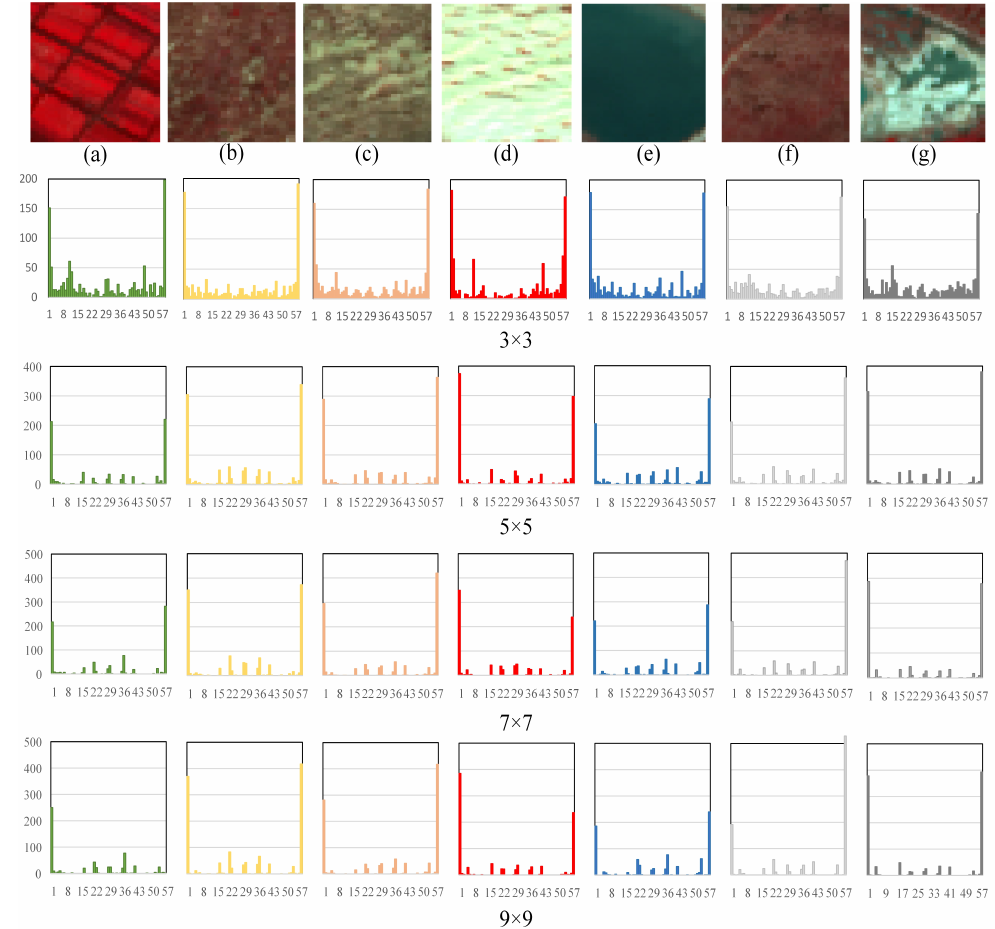
Figure 8. Different scale feature map of cultivated land. ( a ) Non-desertification. ( b ) Mild wind-eroded desertification. ( c ) Moderate wind-eroded desertification. ( d ) Severe wind-eroded desertification. ( e ) Lake. ( f ) Mild salinization. ( g ) Severe